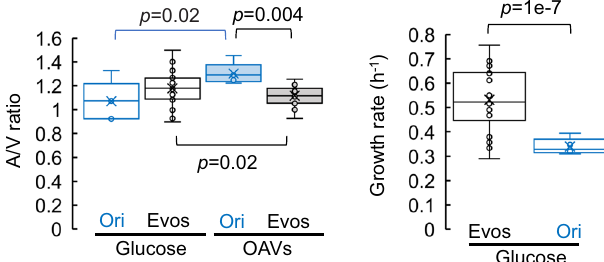
Fig. 6 Changes in the area-to-volume ratio. A Boxplots of the area-to- volume ratios. The Ori (blue) and Evos (black) grown in the presence of either OAVs (shadowed boxes) or glucose (open boxes) are shown. The mean area-to-volume (A/V) ratios of the cell populations (measurements) are indicated as circles. The medians and the averages of the mean A/V ratios are represented as lines and crosses inside the box, respectively. Statistical signi fi cance is indicated as the p- value. B Growth rate in glucose. Blue and black indicate the Ori and Evos, respectively. The growth rates of repeated measurements are indicated as circles. The medians and the averages of the growth rates are represented as lines and crosses inside the box, respectively. Statistical signi fi cance is indicated as the p-